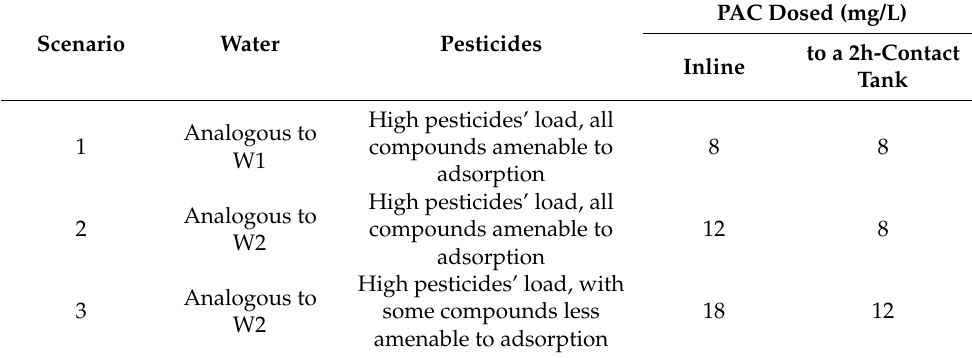
Table 7. Three scenarios considered for cost